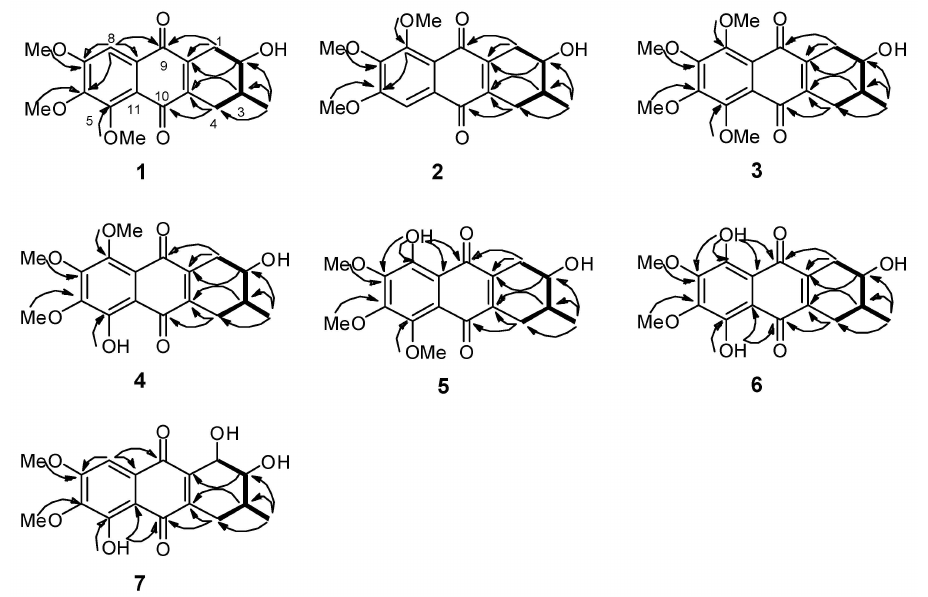
Figure 2. Key 1 H- 1 H COSY (bold) and HMBC (arrows) correlations of 1 – 7